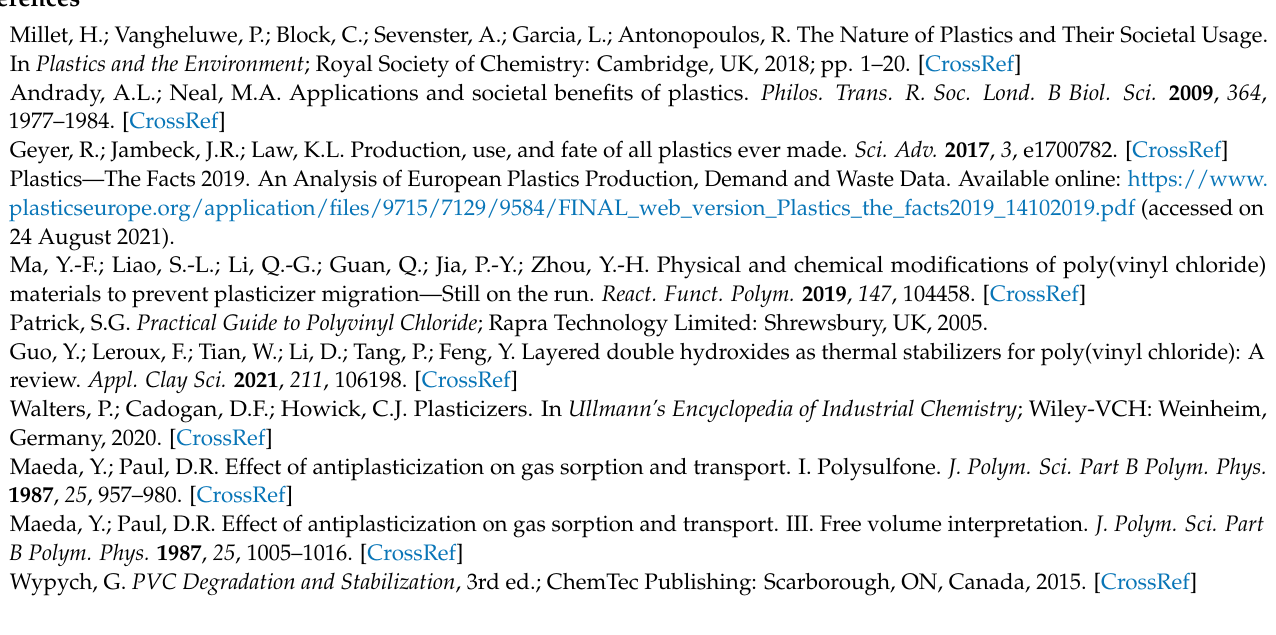
FTIR spectrum of 3 ; Figure S4: 1 H NMR spectrum of 3 ; and Figure S5: 13 C NMR spectrum of 3